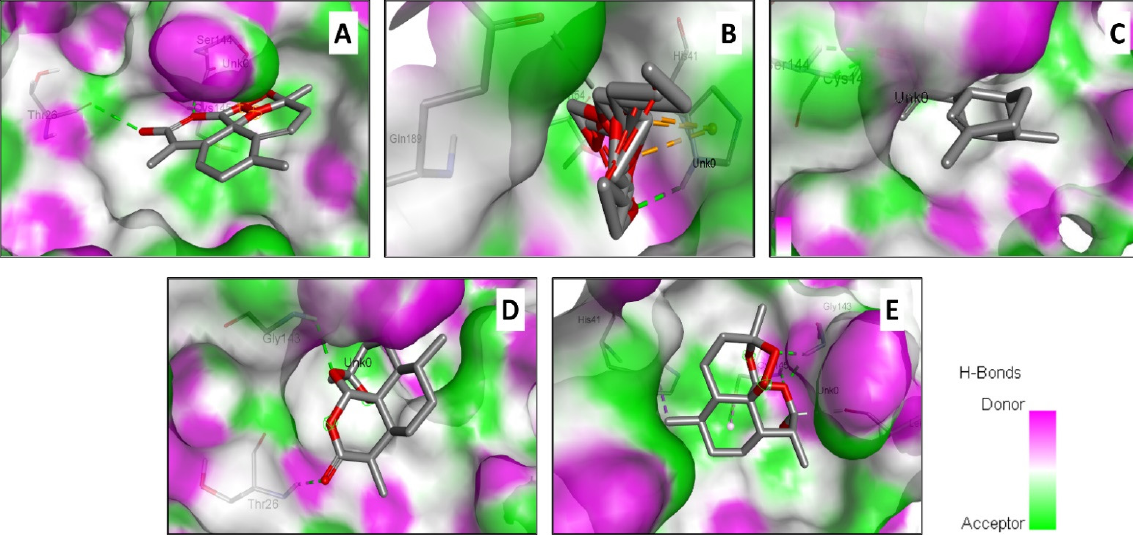
Figure 2. Illustration of the H-bond acceptor and donor interactions and the 3D-binding conformation of the Artemisia campestris selected compounds (( A ) artemisinin, ( B ) acetate of dihydroartemisinin ( C ) artemisinic aldehyde, ( D ) deoxyartemisinin, and ( E ) dihydroartemisinin) docked to the pocket region of the SARS-CoV-2 main protease (6LU7). Table 2 exhibits the binding results. All the assessed compounds showed negative binding energy ranging from − 5.2 to − 8.1 kcal/mol. The highest binding score was found with the acetate of dihydroartemisinin ( − 8.1), followed by artemisinin ( − 7.2). The latter exhibited the highest number of conventional hydrogen bonds, similar to dihydroartemis- inin and the reference compound. Regardless of artemisinic aldehyde, all the herb selected compound showed better affinities than the referenced drug: chloroquine (Table 2). These hydrogen bounds are represented in Figure 3. Table 2. Binding affinity, conventional hydrogen bonds and interacting residues of the main Arte- misia campestris docked compounds into the SARS-CoV-2 Mpro (6LU7). Compound Name Binding Affinity ( kcal/mol )